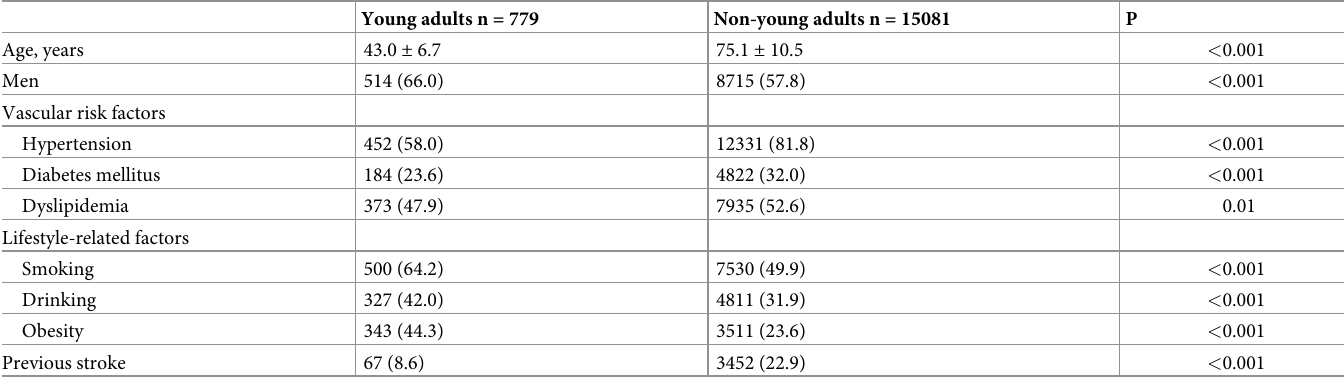
Table 1. Background characteristics of young adults and non-young